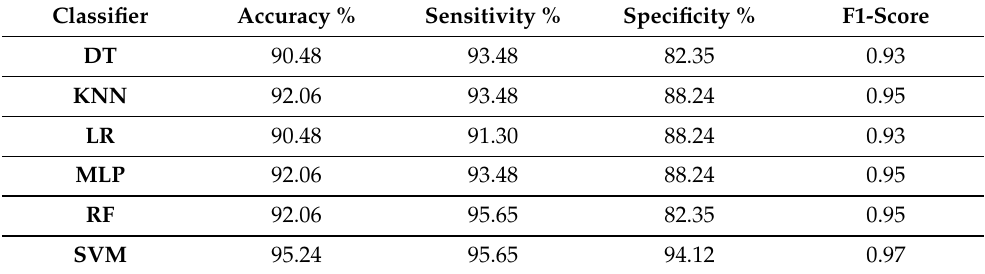
Table 3. The evaluation metrics of different ML classifiers using LOSO cross-validation approach, along with the integrated group of extracted features.